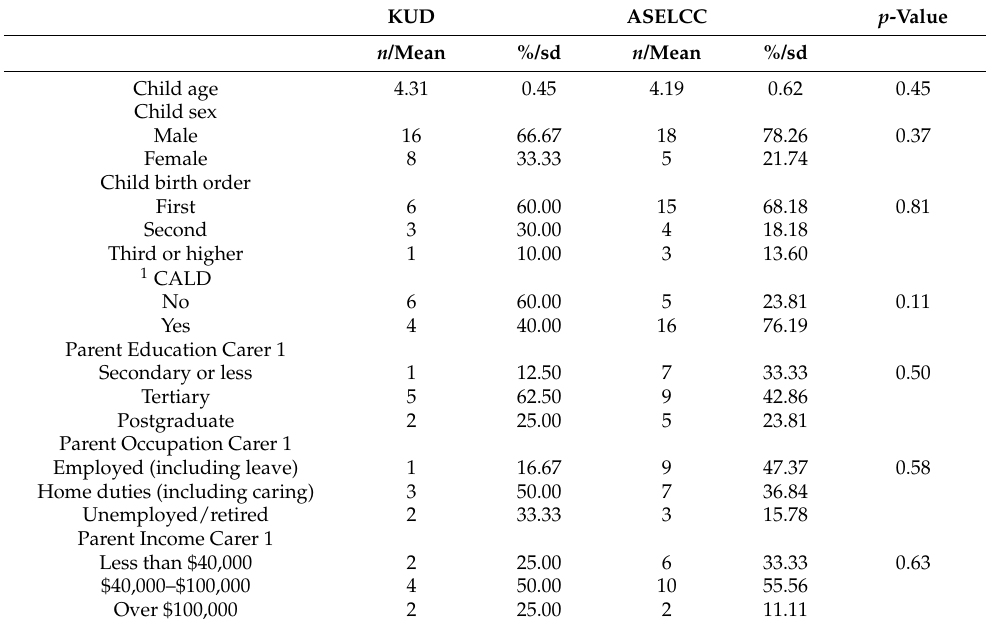
Table 1. Participant demographic statistics.